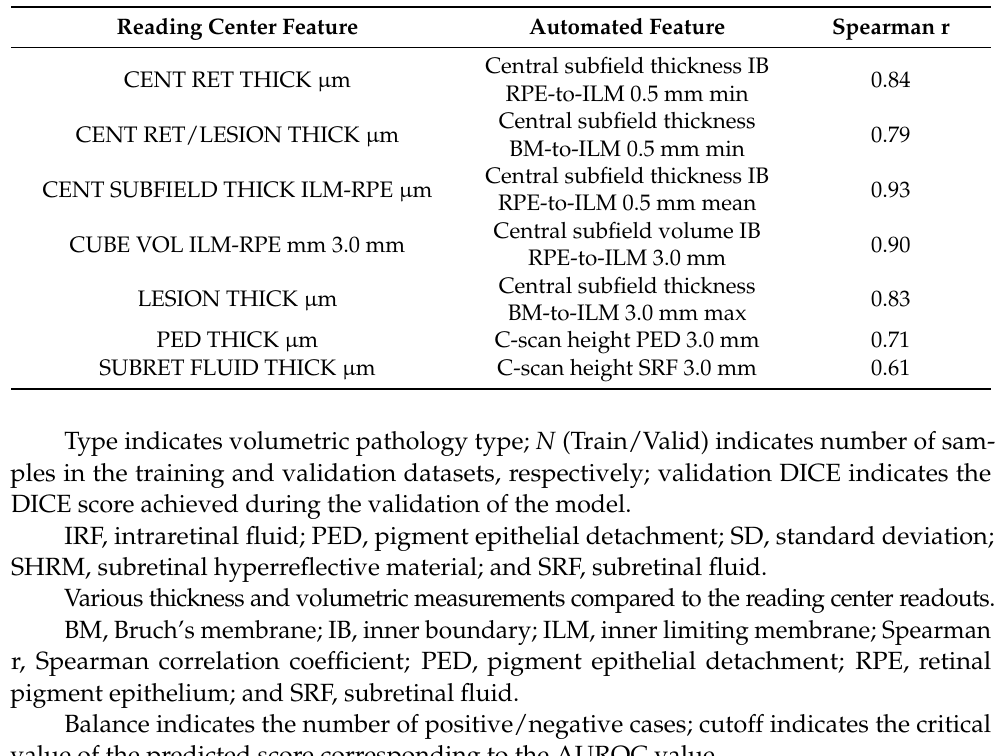
Table 2. Human Readouts vs. Automated Readouts for AVENUE. Many automated readouts were generated. This table demonstrates that there was a high correlation between manual readouts that most clearly correspond to the automated [MA1]